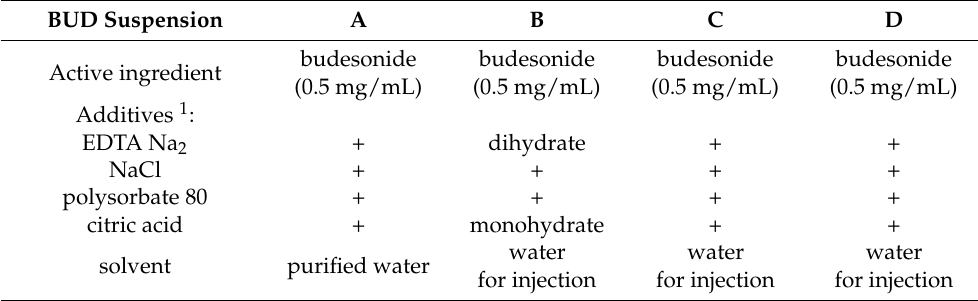
Table 1. Composition of BUD suspensions (data according to the product leaflets).